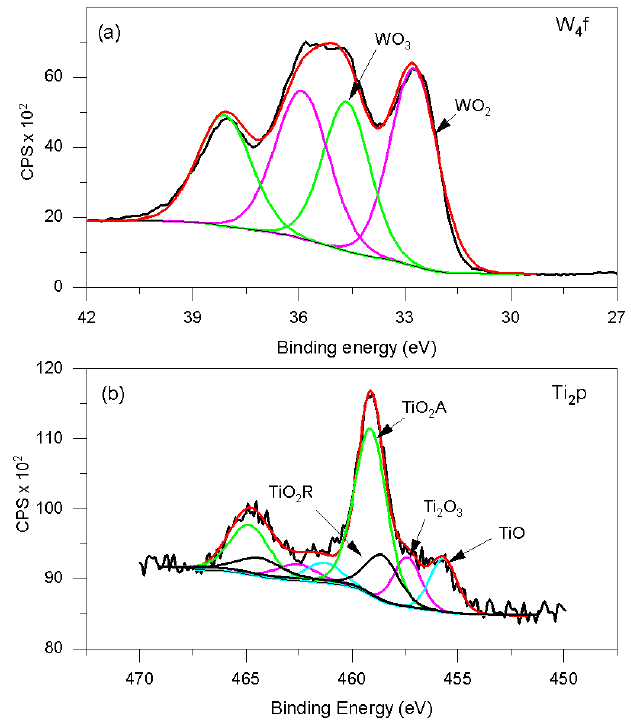
Figure 12. XPS analysis of wear products on the tread in WTi coatings. ( a ) spectra for W4f Tungsten; ( b ) spectra for Ti2p Titanium.